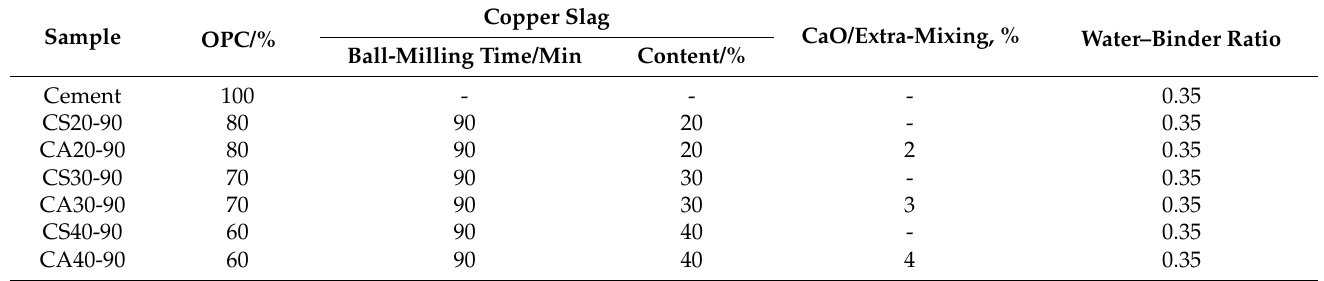
Table 3. Mixing ratio of mechanical–chemical coupling-activated copper slag-based composite cement